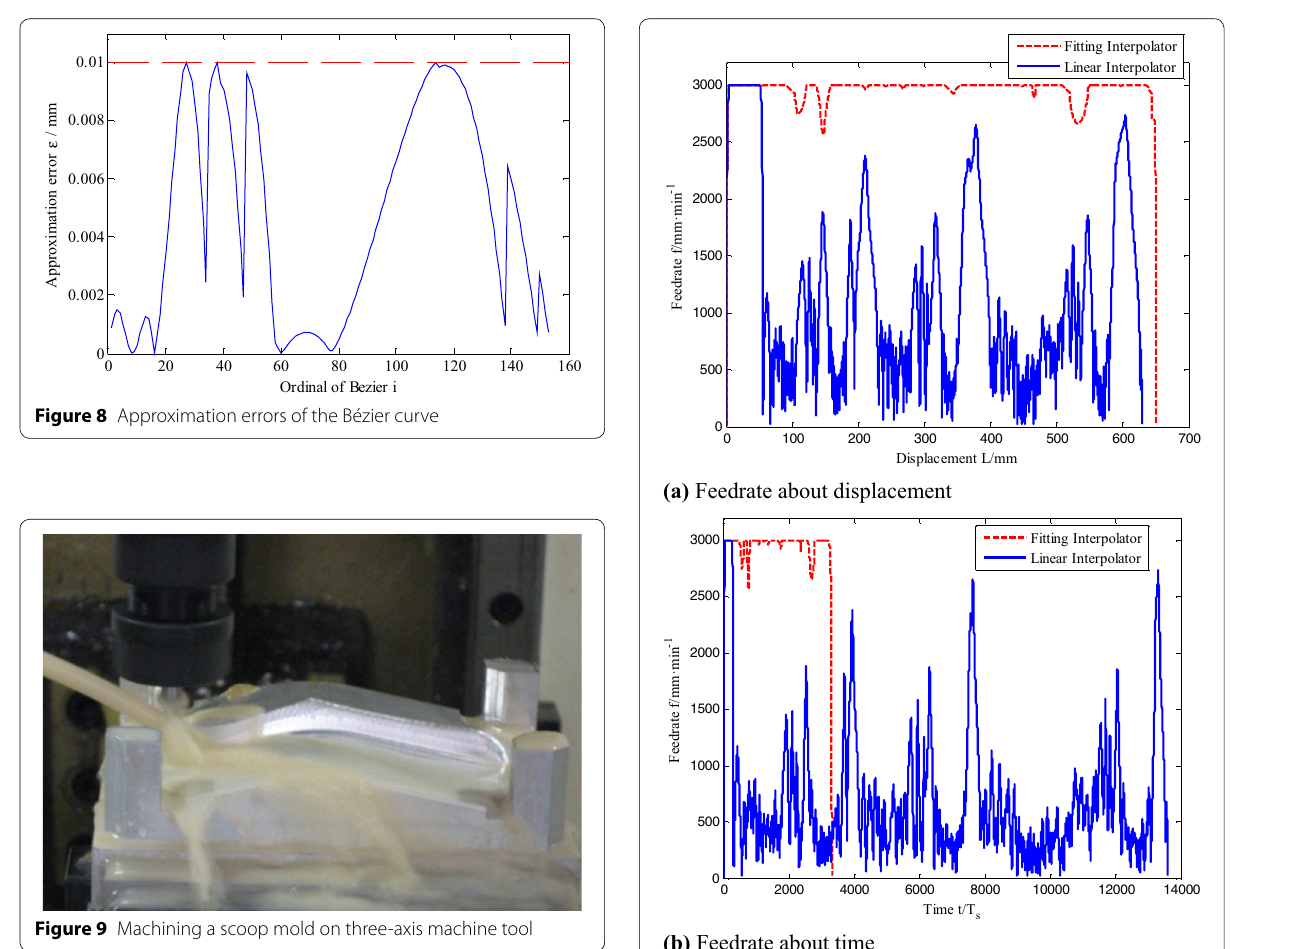
(b) Feedrate about time Figure 11 Feedrate profiles generated by two different interpolation methods